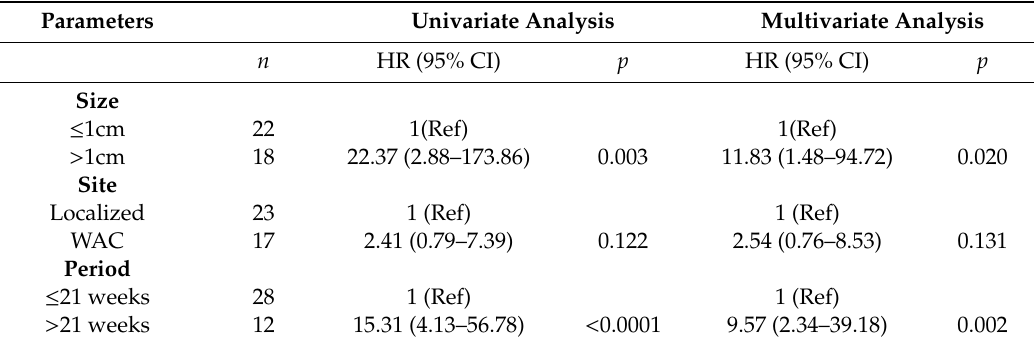
Table 4. Association between baseline characteristics and overall